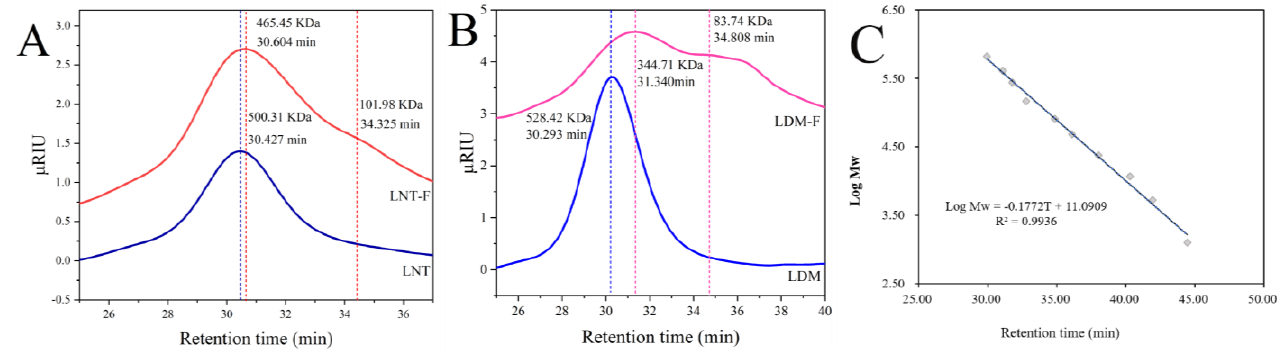
Figure 3. The HPGPC chromatogram of samples. ( A ) Lentinula edodes powder (LNT) and fermented LNT (LNT-F) samples, ( B ) soybean powder (LDM) and fermented LDM (LDM-F) samples, ( C ) calibration standards curve of Mw.